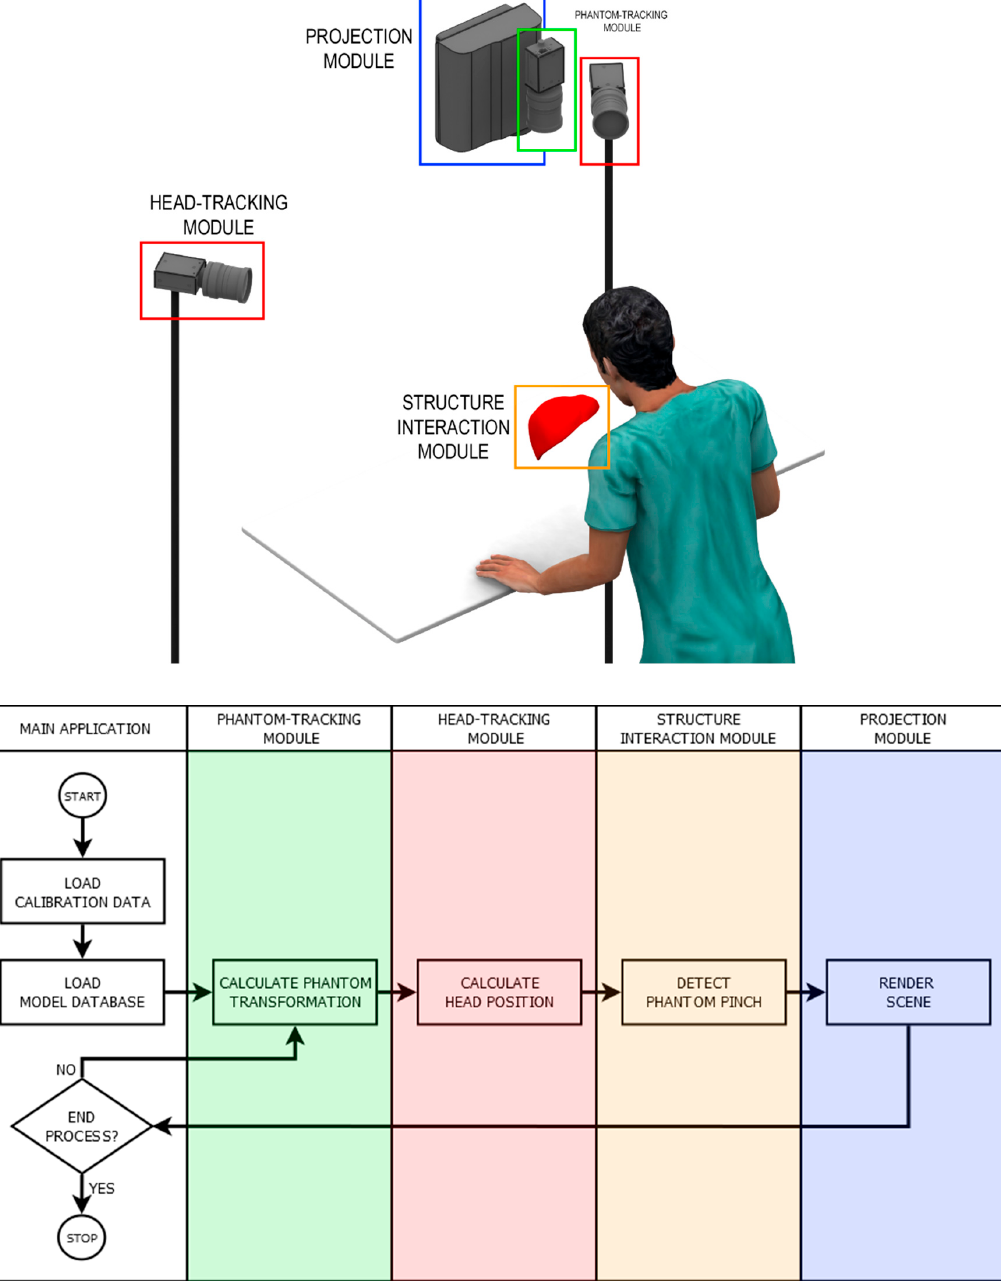
Figure 1. MARVIS system ( top ) and subsystem flowchart ( bottom ).